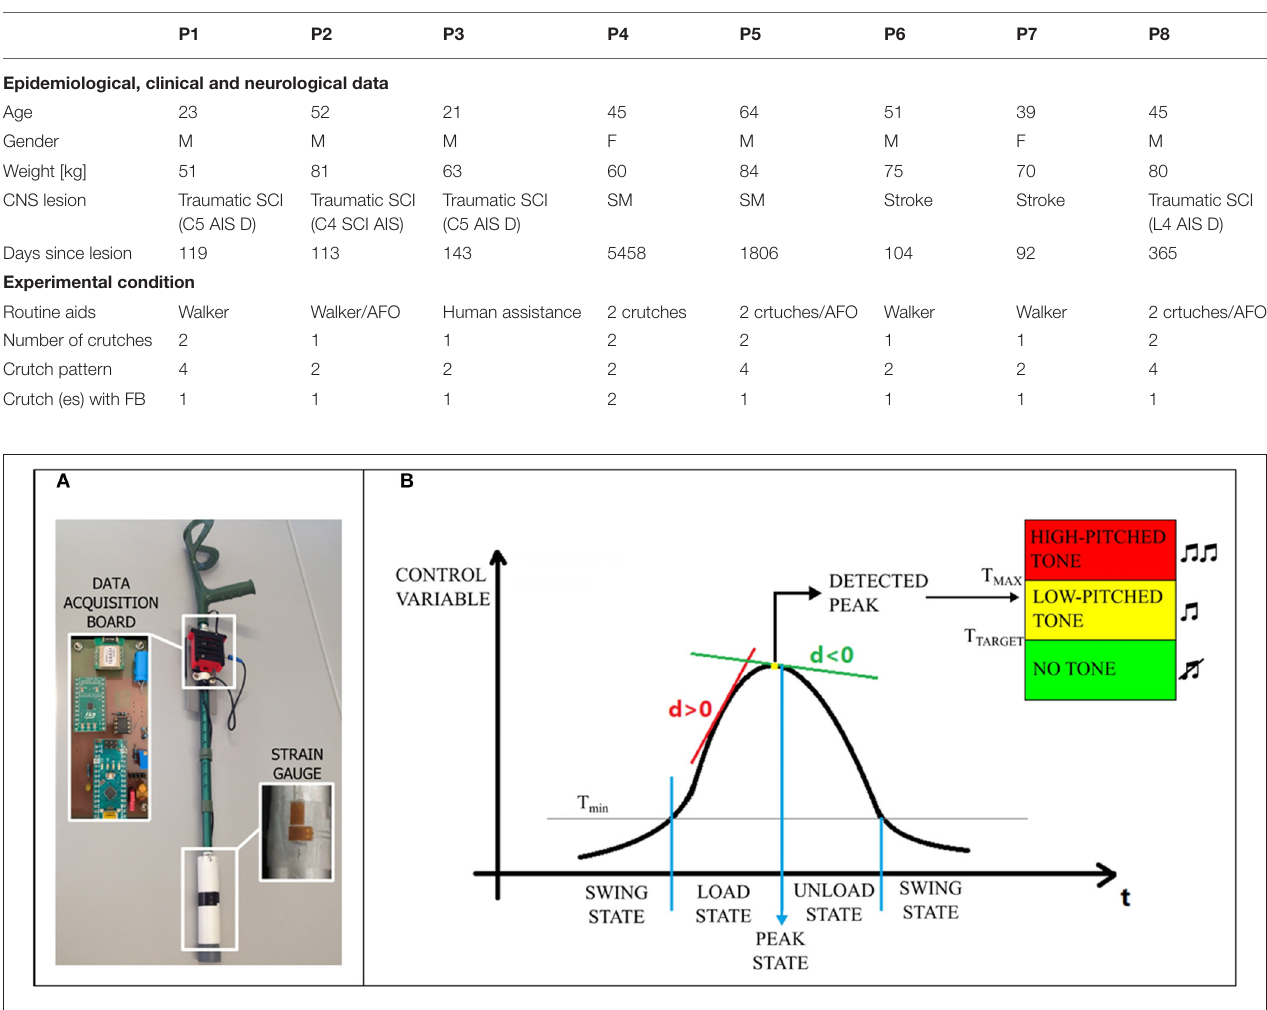
TABLE 1 | Epidemiological, clinical, neurological data, and experimental conditions for each participants (P1–P8). P1 P2 P3